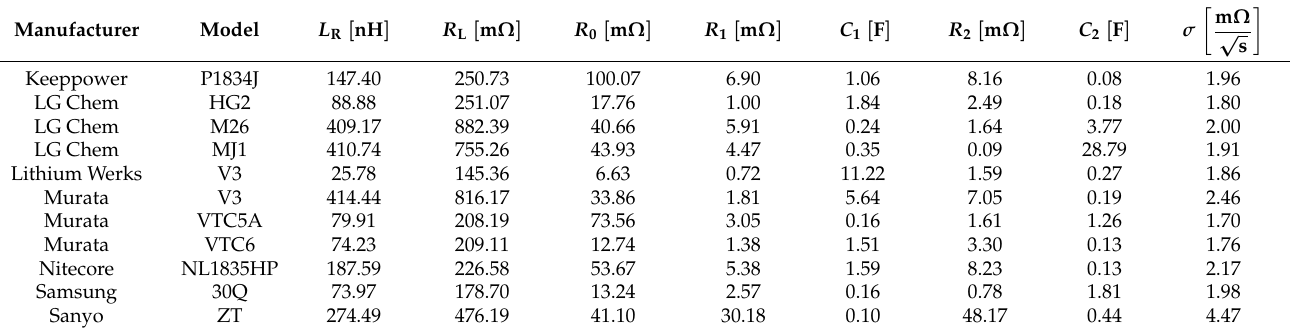
Table 2. Estimated battery parameters for the Warburg impedance